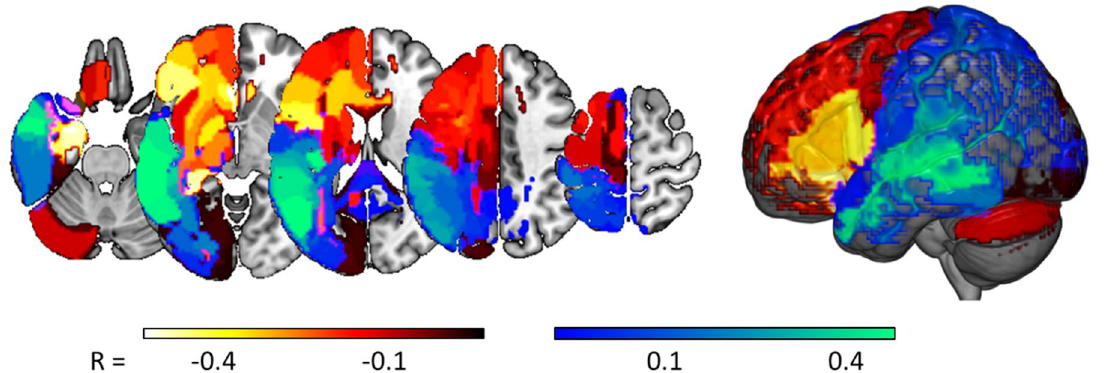
Figure 2. Relating lesion locations to predicted treatment responses. Correlation coefficients, derived via data perturbation, relating the lesion load in each of 177 regions, to treatment responses predicted by our best model (appending lesion data to the hours of therapy actually